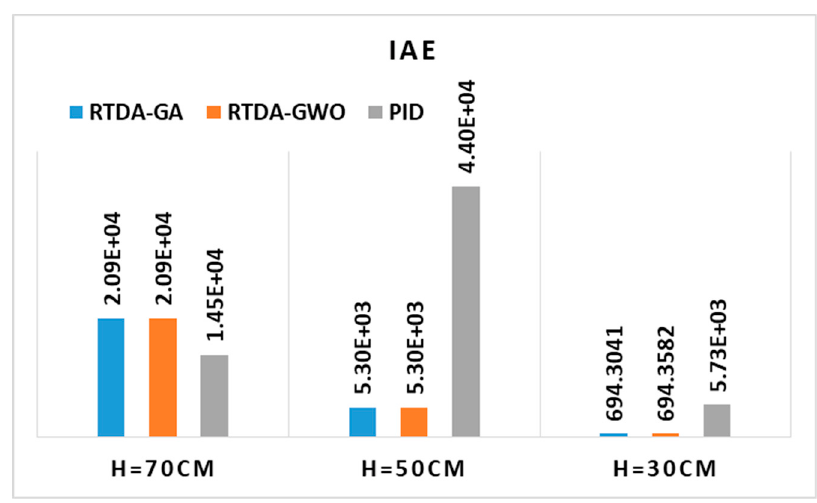
Figure 14. Case - 2: IAE Performance comparison chart between RTD-A and PID